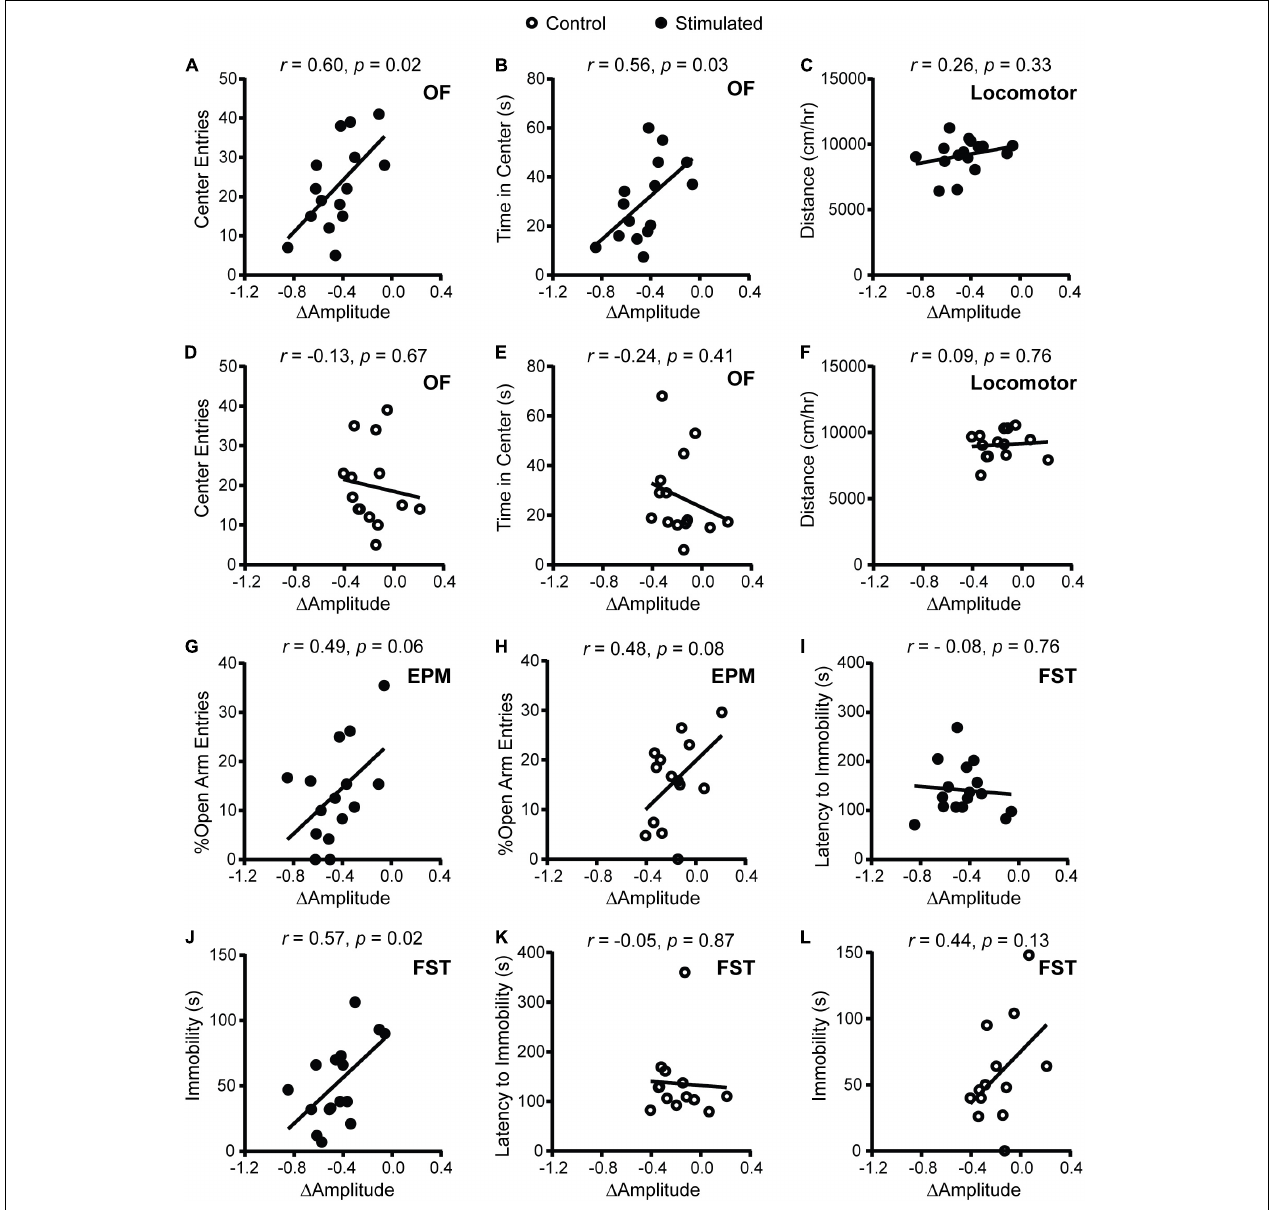
FIGURE 2 | Correlations between change in homecage activity amplitude and behavior in mice that received stimulations or sham stimulations of the SCN at CT21. (A,B,D,E) OF, (C,F) locomotor, (G,H) EPM, (I–L) FST. A dampened amplitude of homecage activity rhythms in stimulated mice was correlated with increased anxiety-like behavior in the OF and decreased immobility in the FST. n = 13–16 Vgat -Cre;ChR2